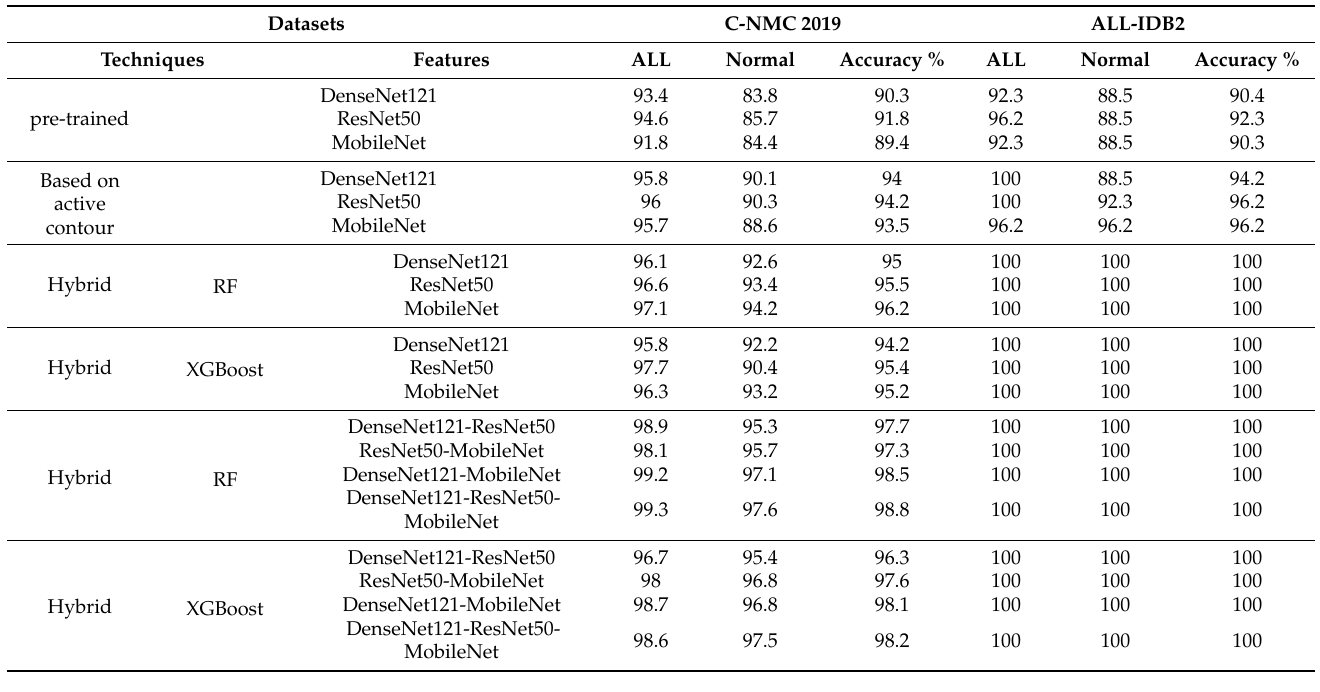
Table 8. Results of all proposed systems for diagnosing images of the NMC 2019 and ALL-IDB2 datasets based on hybrid technologies and fused features.